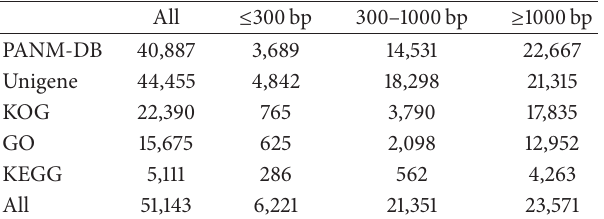
Table 3: Comparison of the number of unigene annotations obtained from the different protein databases. The number of unigenes hits from locally curable PANM-DB, Unigene, KOG, GO, and KEGG databases, respectively, using BLASTX search ( 𝐸 -value ≤ 1𝐸 − 5